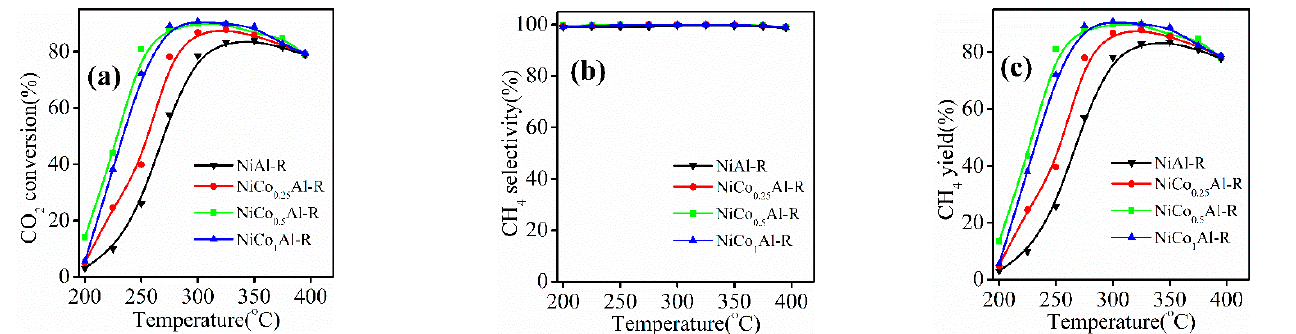
Figure 8. Catalytic performances of NiCo x Al-R for CO 2 methanation: ( a ) CO 2 conversion, ( b ) CH 4 selectivity, ( c ) CH 4 yield.